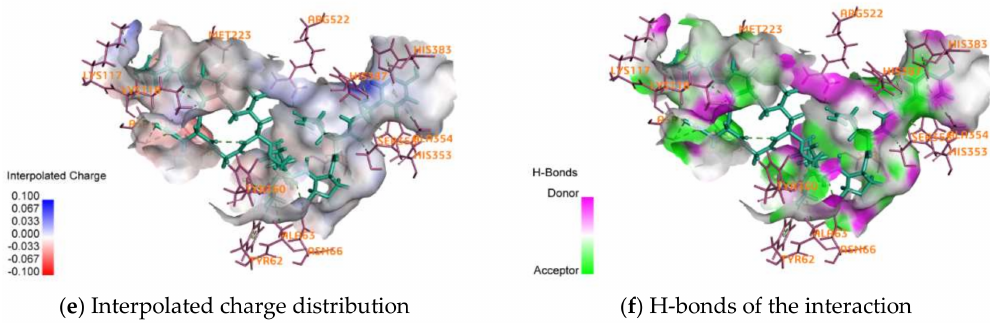
Figure 5. Molecular docking of EPNGLLLPQY against ACE (PDB: 1O8A). Table 3. Interaction bonds of walnut peptide against